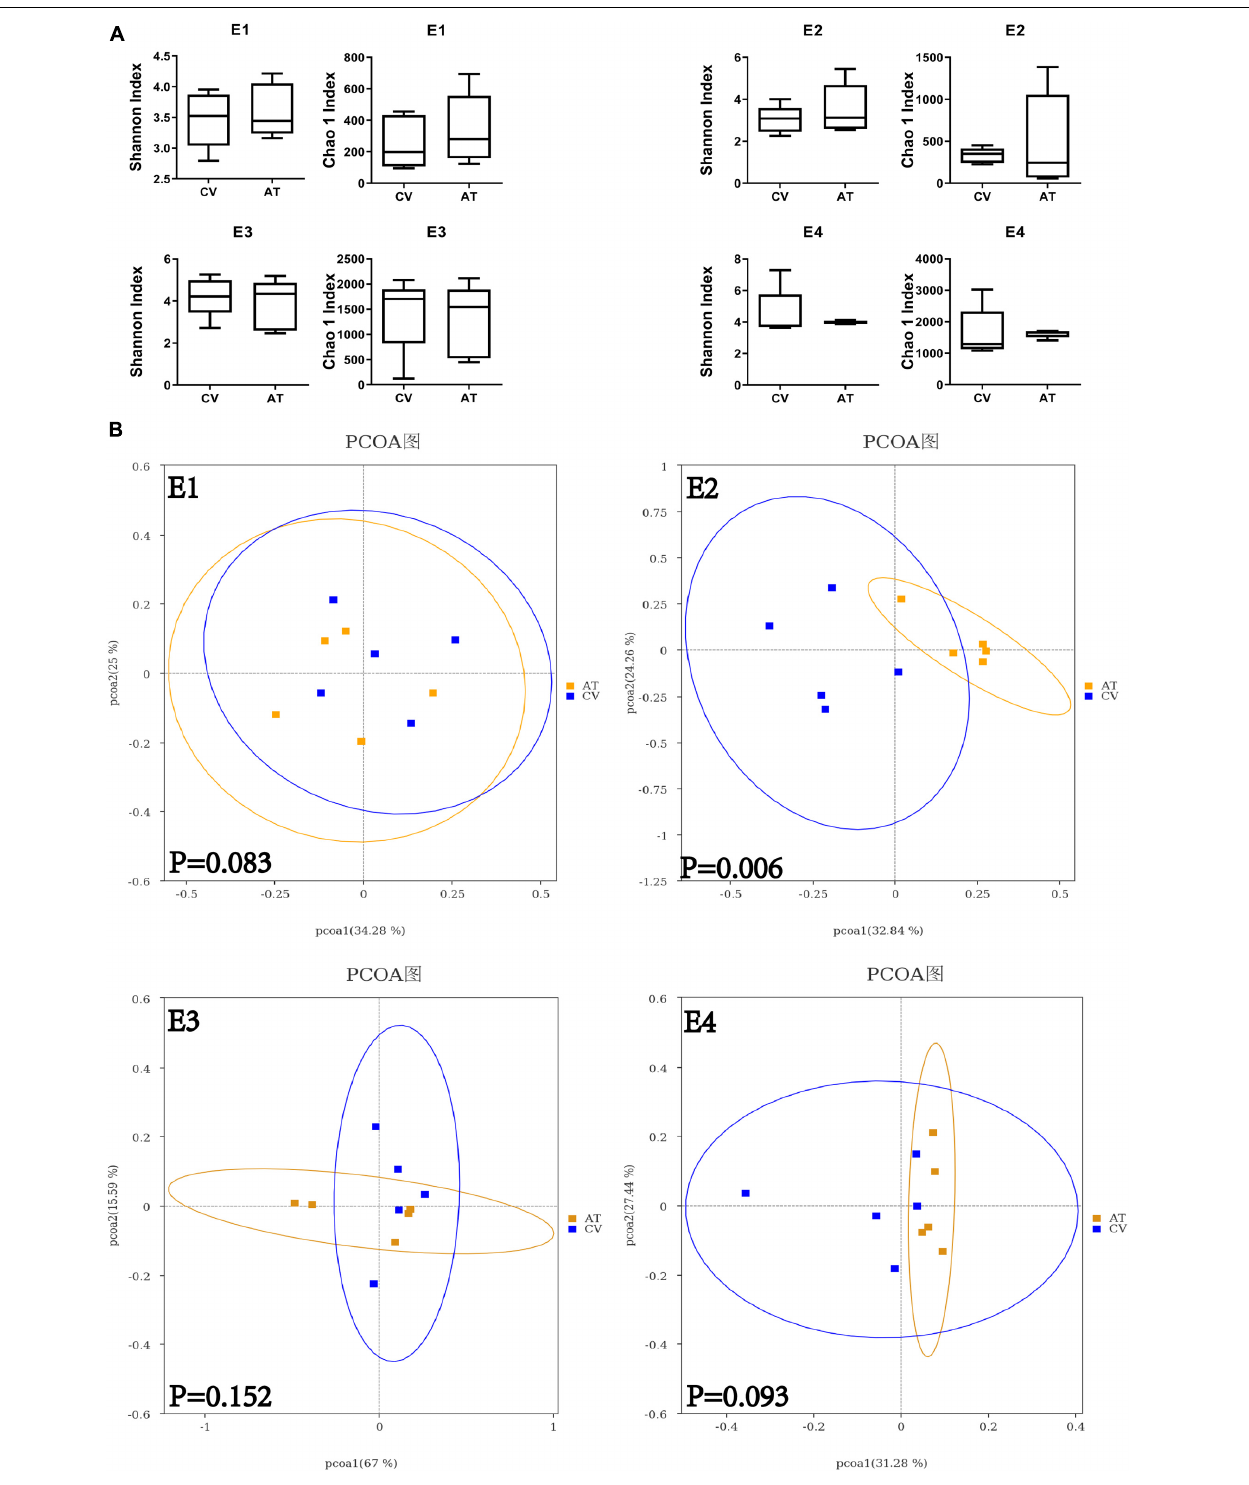
FIGURE 2 | Alpha and beta diversity of CV and AT honey bee workers. (A) Difference in alpha diversity between CV and AT workers measured using Shannon index and Chao 1 index. (B) The principal coordinate analysis (bray-Curtis) in gut community between CV and AT workers. E1–E4 represent four experimental replicates with four different honey bee